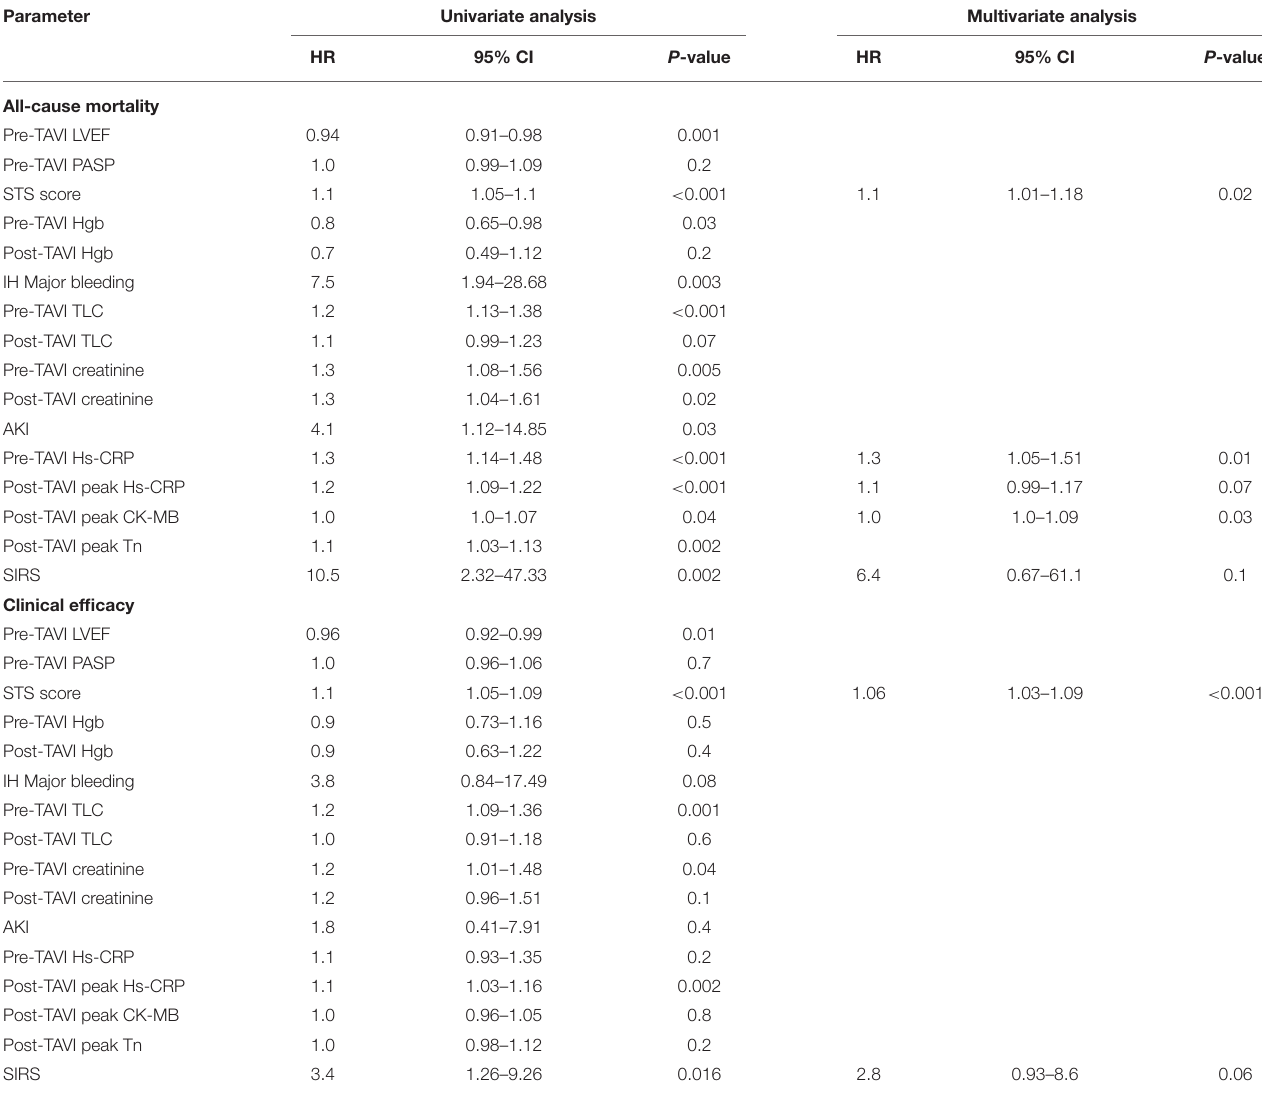
TABLE 8 | Cox regression analysis for the predictors of overall mortality and clinical